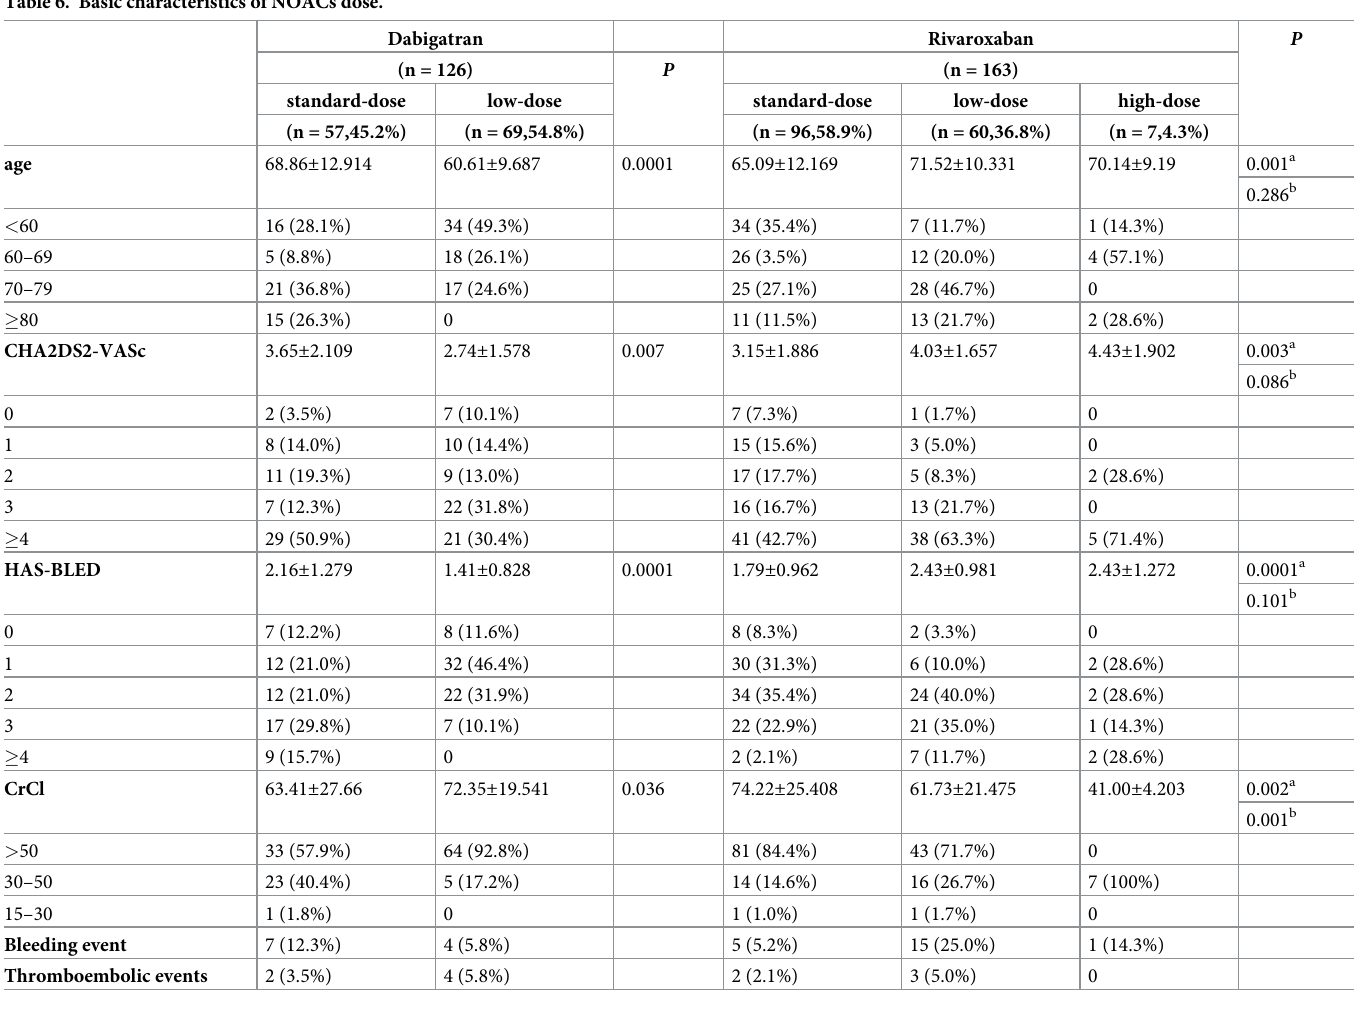
Table 6. Basic characteristics of NOACs dose.